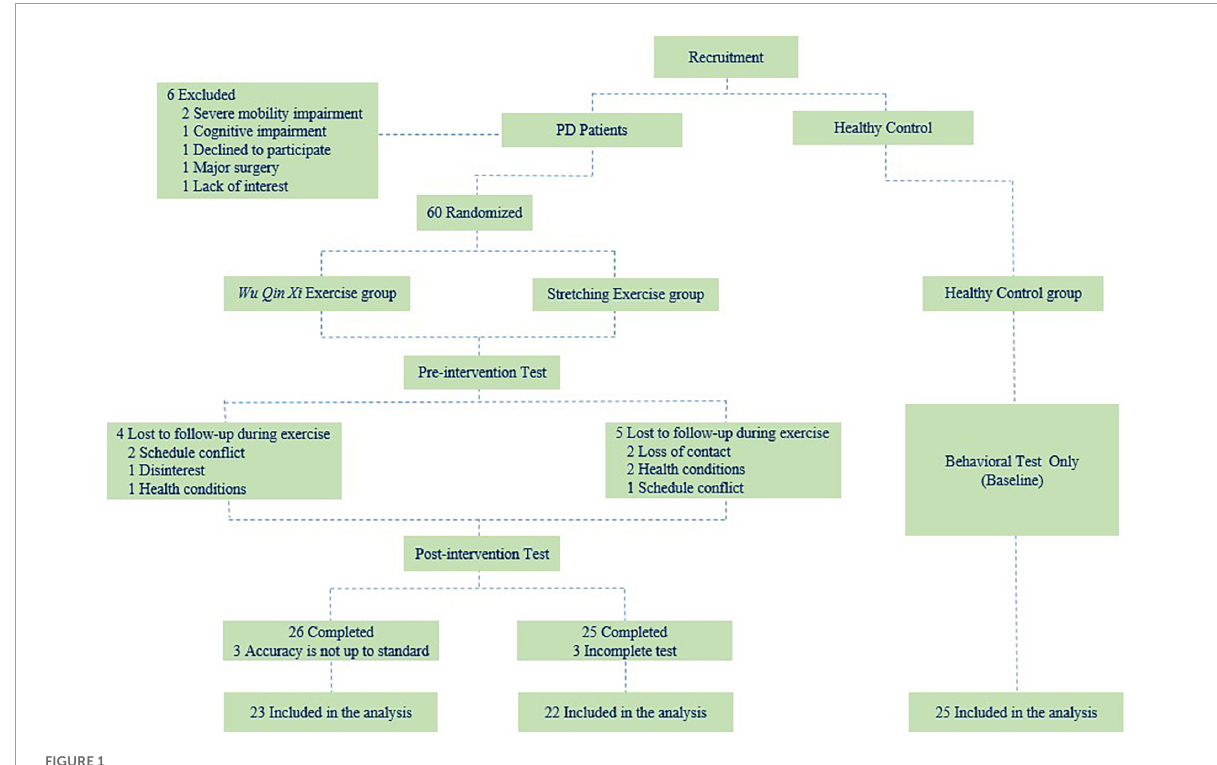
FIGURE1 Study flow. Flow diagram of the study